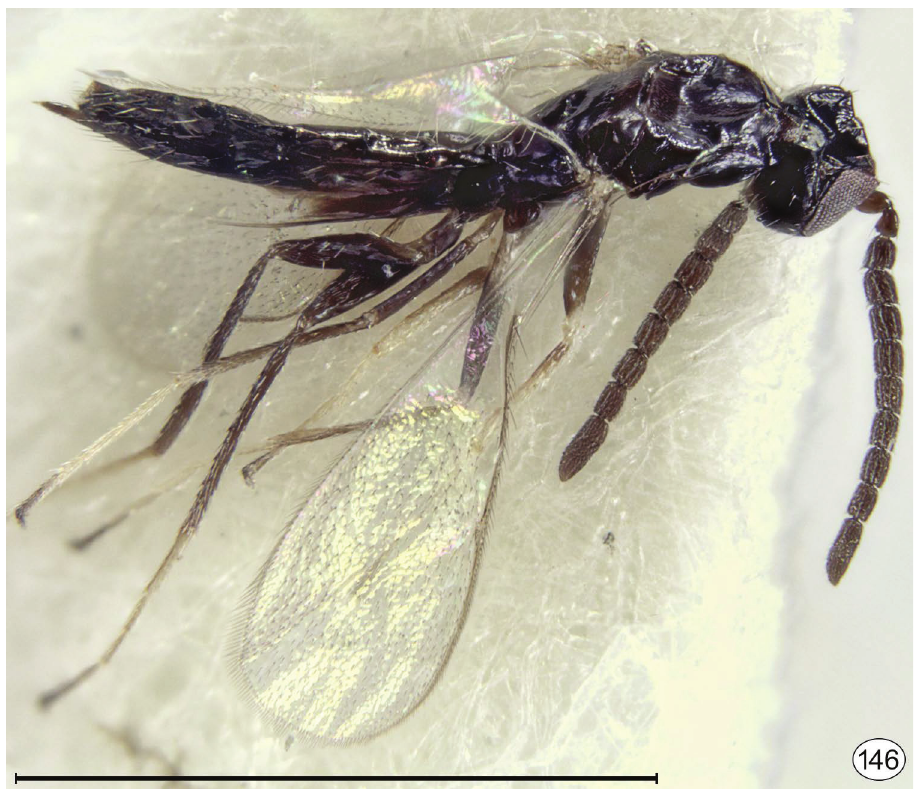
Figure 146. Neotriadomerus sp. 2, female habitus, lateral (Australia, WA, 29 km SE by E of Coolgardie, 31.07°S, 121.24°E, 5.v.1983). Scale bar = 1000 μm. Comment. Body length 1920; fore wing with cubital line of setae extending to base of parastigma. This specimen is similar to the female from Blundells Creek but fl is even shorter than fl so it is provisionally treated as distinct. 2